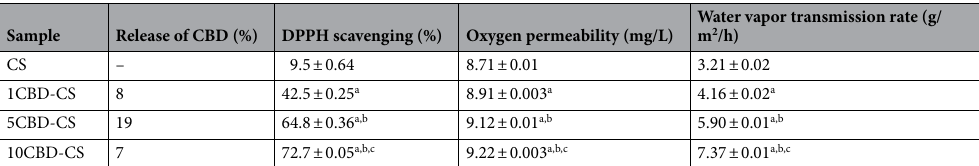
Table 3. The properties determined for the obtained films. CBD-CS—cannabidiol-chitosan-based films, where 1, 5, 10CBD-CS corresponds to the weight ratio of 1, 5 or 10% of cannabidiol oil (CBD) to chitosan (CS). a,b,c Indicate p < 0.05 when compared to the corresponding CS, 1CBD-CS and 5CBD-CS,